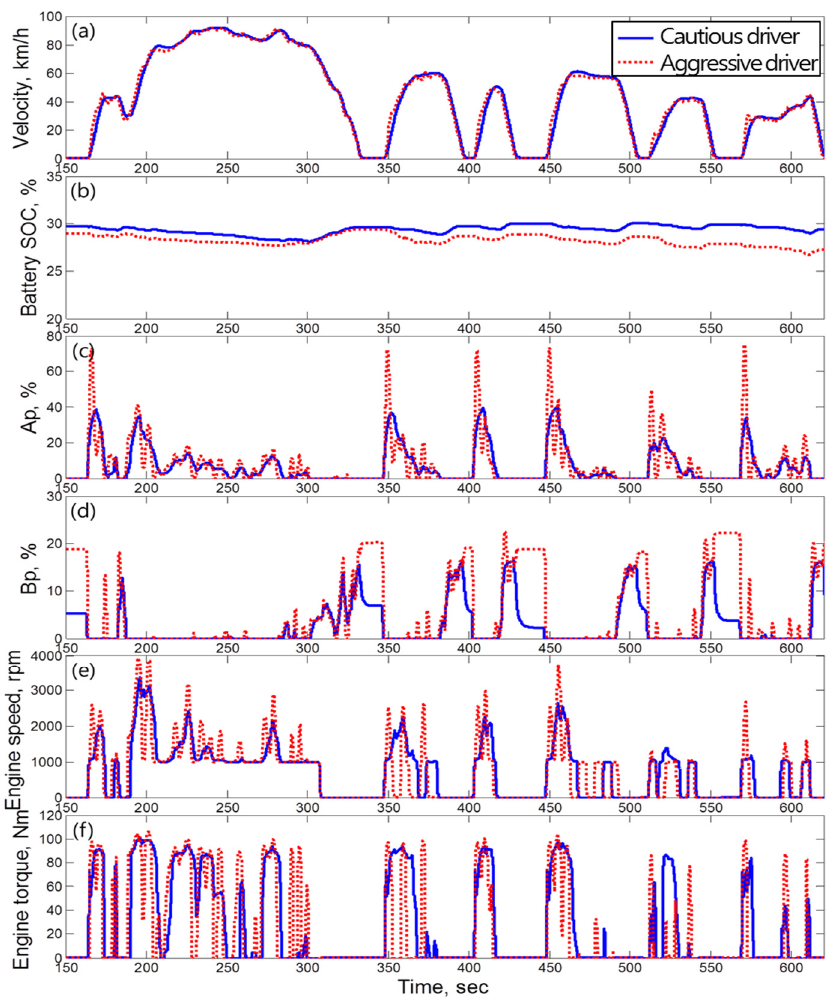
Figure 7. Simulation results of cautious and aggressive driver for the FTP-72